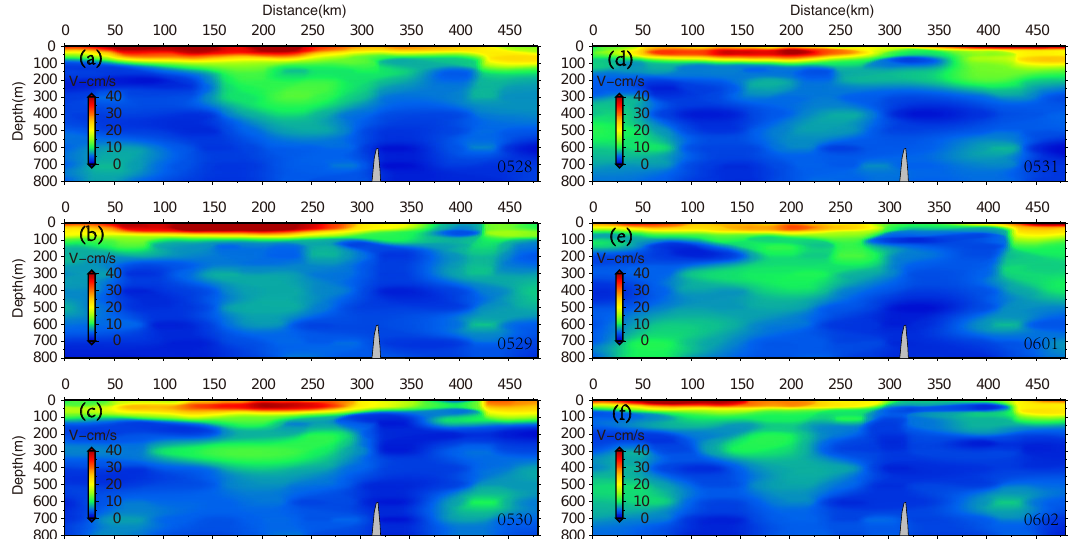
Fig. 7. Daily speeds of the HYCOM results along the transect from 28 May to 2 June 2009.